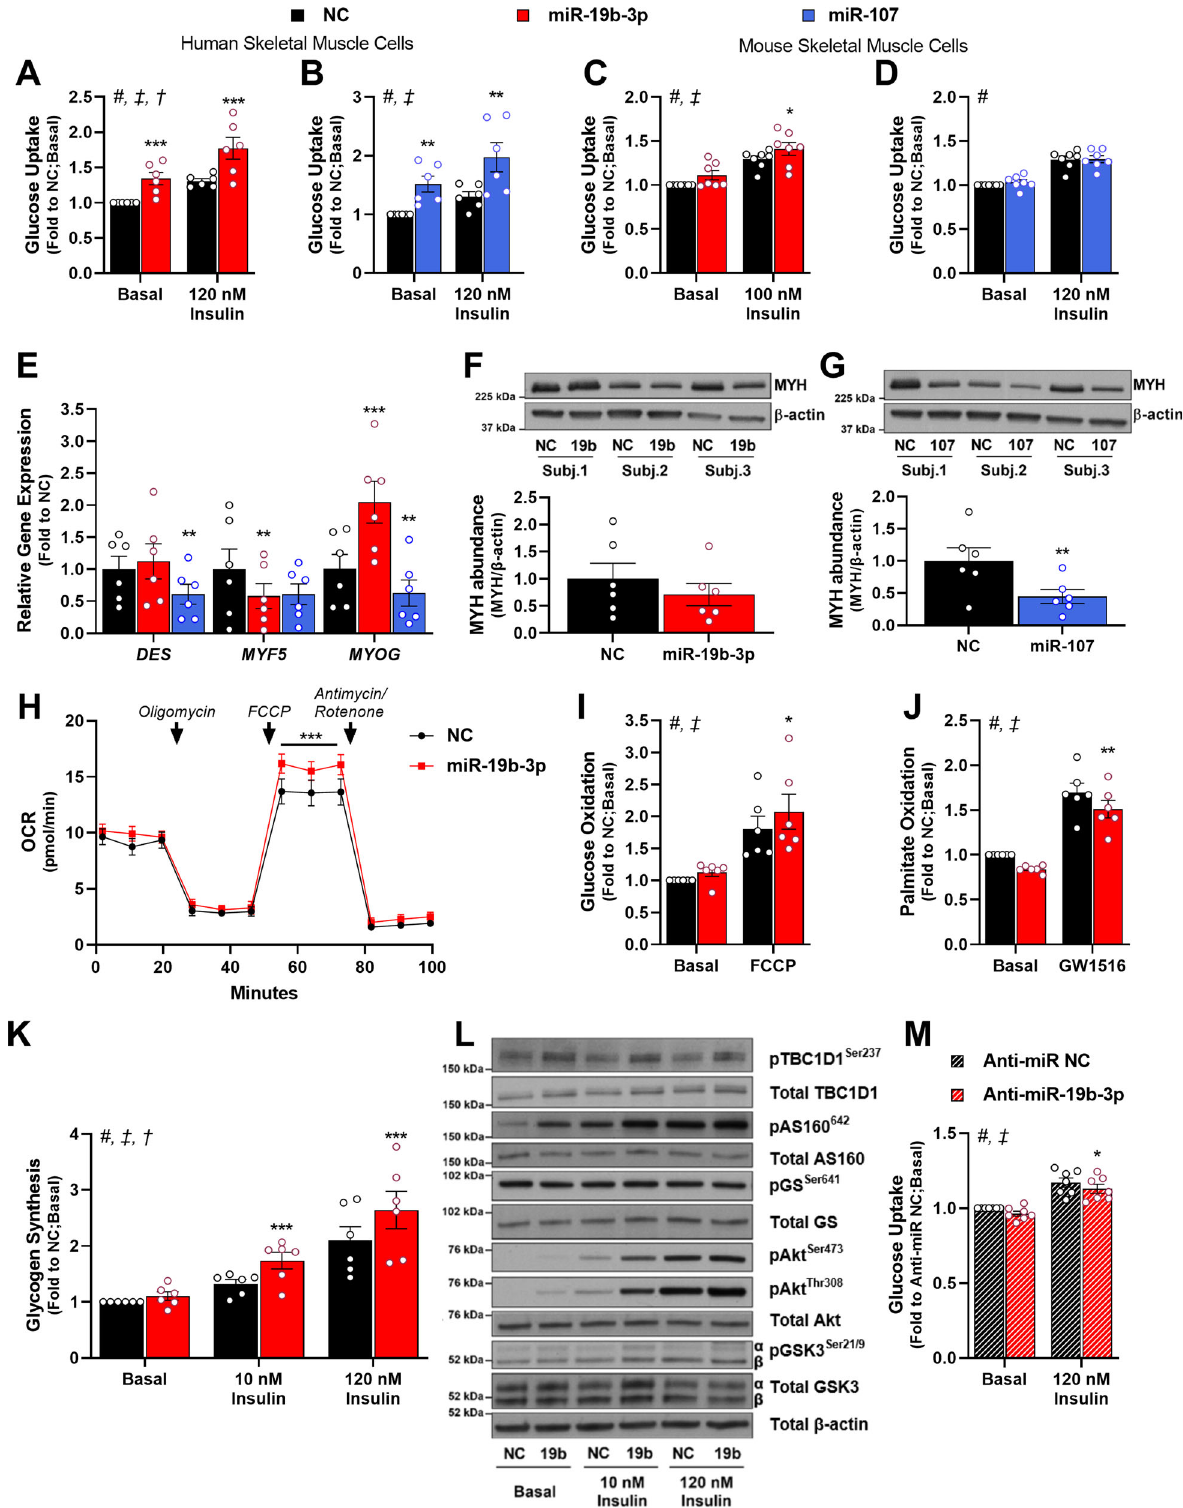
expression of MYOG (Fig. 2E), and was without effect on myosin heavy chain 1 and 2 (MYH1/2) protein abundance (Fig. 2F). Conversely, miR-107 overexpression decreased the expression of DES and MYOG and reduced MYH1/2 protein abundance in human skeletal muscle cells (Fig. 2E, G). These results indicate that miR-107 overexpression impairs human skeletal muscle cell